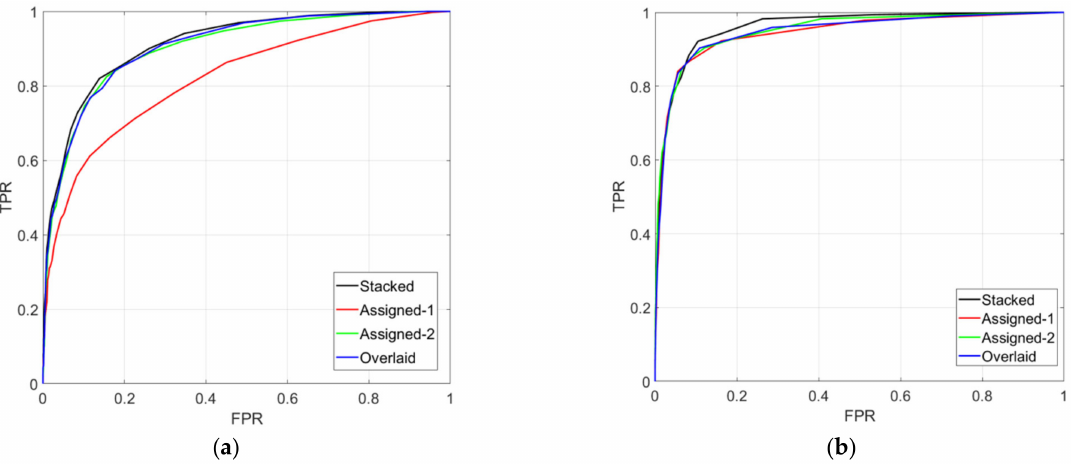
Figure 20. ROC curves of different segmented methods on the two data sets: ( a ) Mingfeng; ( b ) Wuhan